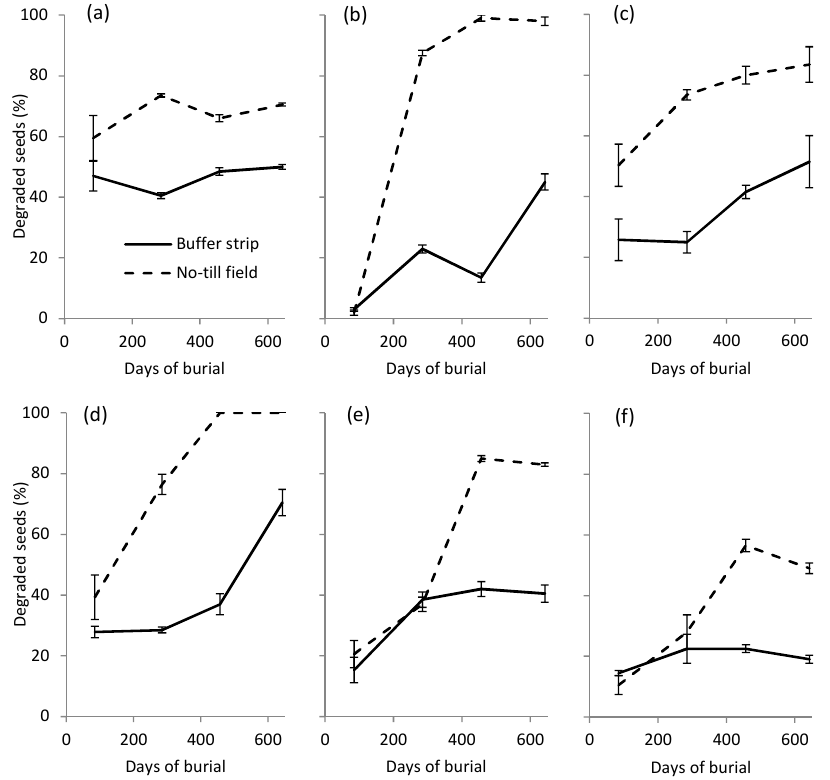
Figure 1. Percentage of degraded seeds after di ff erent days of burial in the soil of the no-till (NT) field and vegetated bu ff er strip (BS). ( a ) A. theophrasti ; ( b ) A. myosuroides ; ( c ) A. retroflexus ; ( d ) D. sanguinalis ; ( e ) P. oleracea ; ( f ) S. halepense